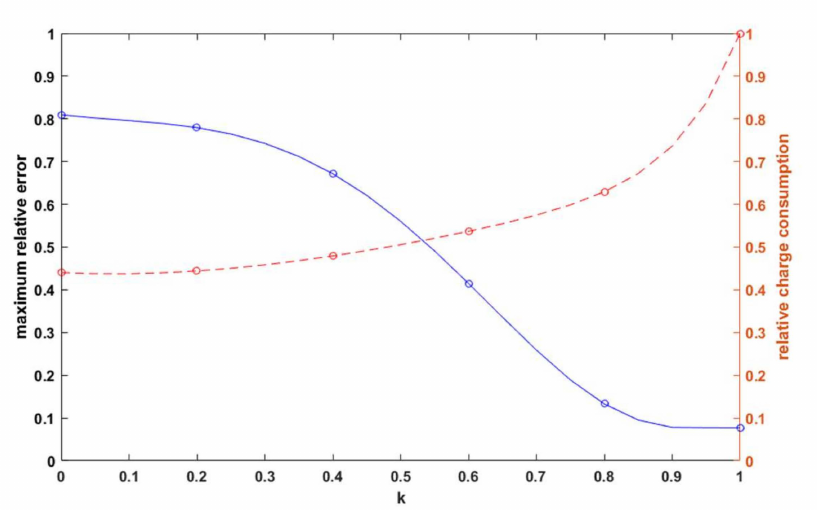
Figure 13. The maximum relative error of the distance estimation and the relative charge consumption as a function of k .